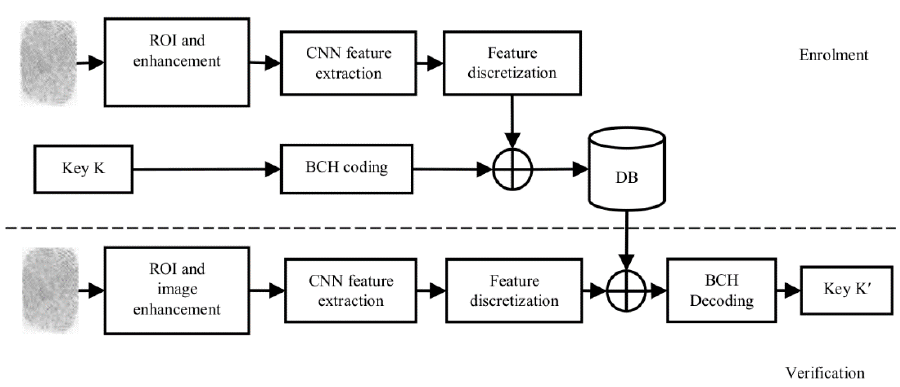
Figure 5. Enrolment and verification phases of the proposed biometric cryptosystem.